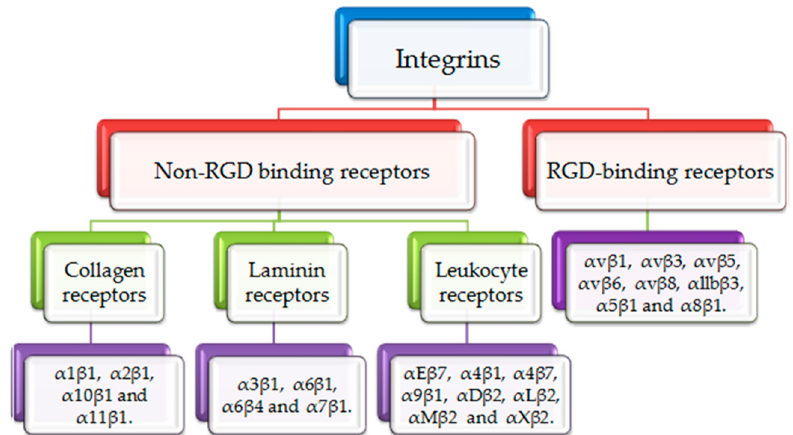
Figure 1. Classification of integrins. Integrins are divided into RGD binding receptors and non-RGD binding receptors. RGD binding receptors include α v β 1, α v β 3, α v β 5, α v β 6, α v β 8, α llb β 3, α 5 β 1 and α 8 β 1. Non-RGD binding receptors include collagen binding receptors ( α 1 β 1, α 2 β 1, α 10 β 1 and α 11 β 1), laminin binding receptors ( α 3 β 1, α 6 β 1, α 6 β 4 and α 7 β 1) and leukocyte binding receptors ( α E β 7, α 4 β 1, α 4 β 7, α 9 β 1, α D β 2, α L β 2, α M β 2 and α X β 2).